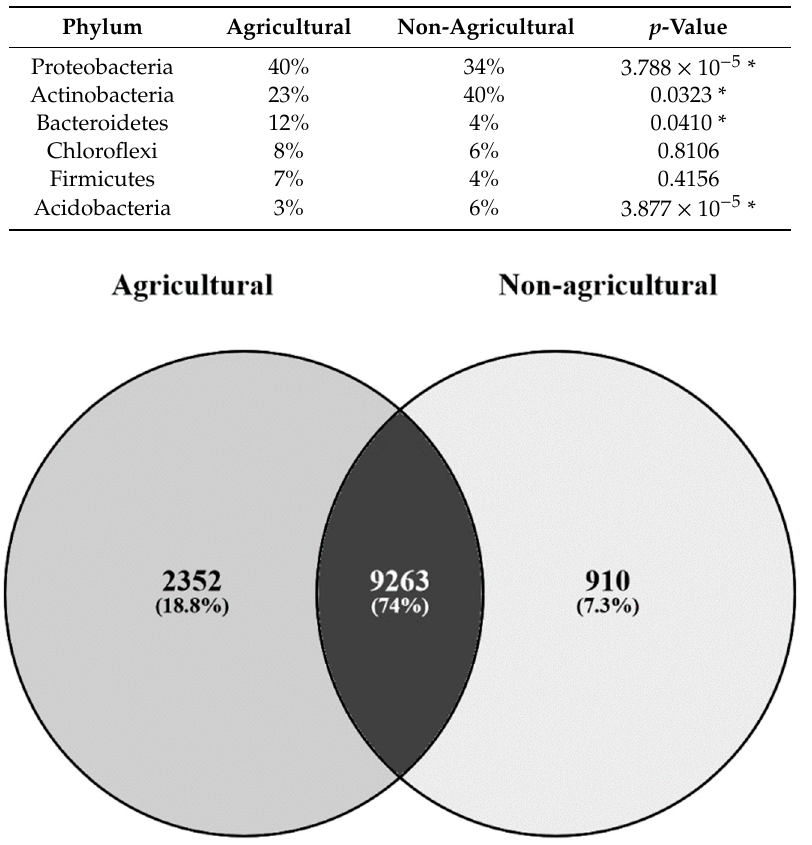
Table 1. Total relative abundance of bacterial phyla detected in agricultural and non-agricultural soil samples from the EFS. P-values marked with an asterisk (*) indicate significant differences ( p < 0.05).